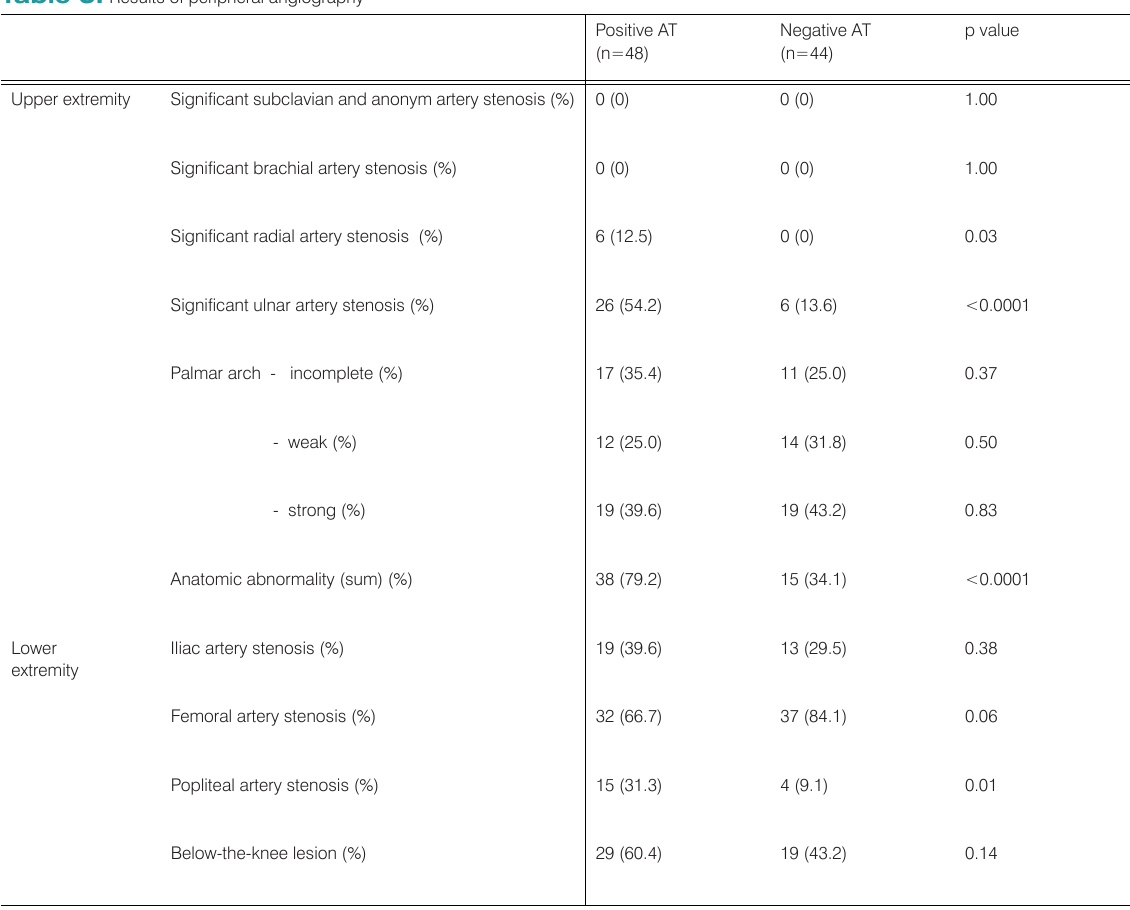
Table 3. Results of peripheral